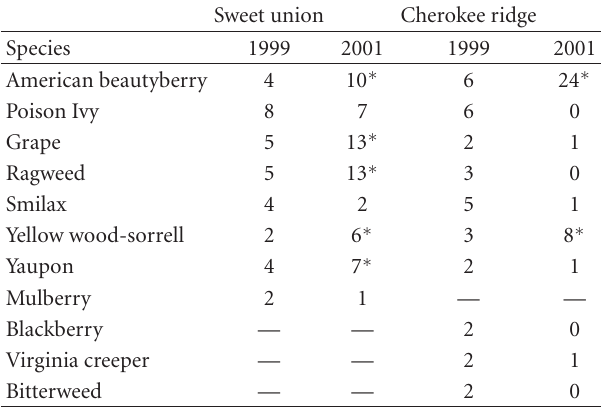
Table 6: Change in importance values (IV) of herbaceous and shrub species at cherokee ridge and sweet union research sites, east Texas, USA between 1999 (pretreatment) and 2001 (2 years posttreatment. ∗ significantly di ff erent at P = .1 from analysis of various test proc GLM (SAS, ver